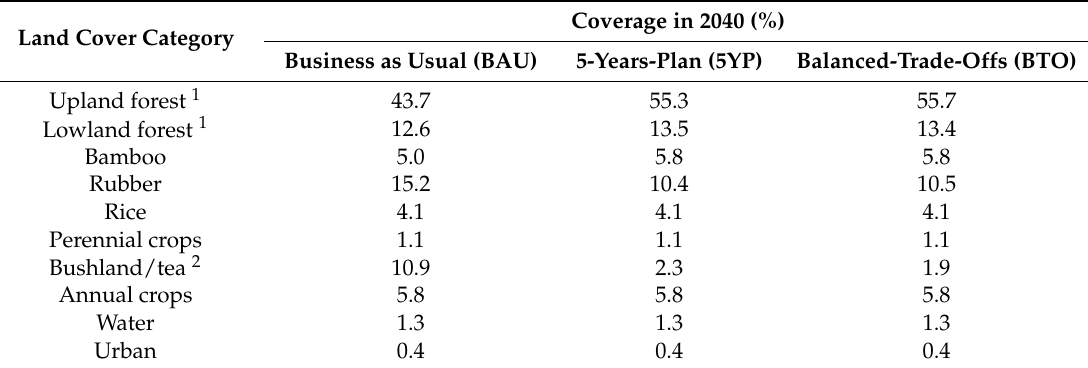
Table 3. Proportions of land cover categories in the Nabanhe Reserve (271 km 2 ) for the final year of each